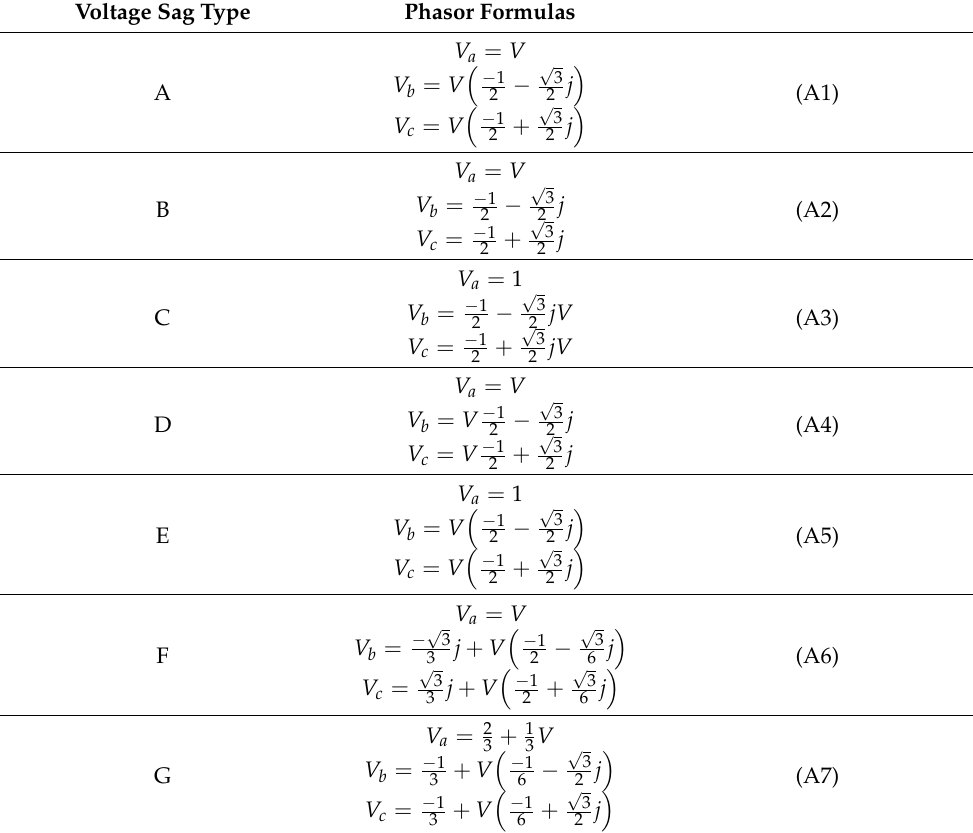
Table A1. List of phasor formulas for each phase per voltage sag